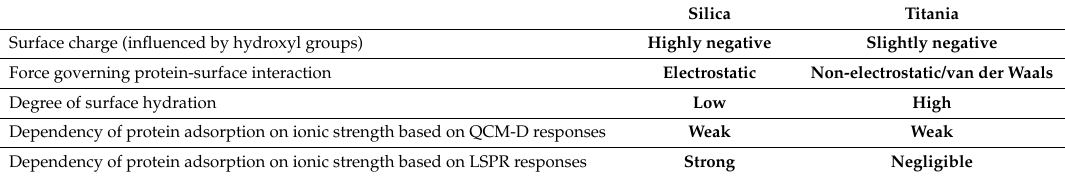
Table 1. Summary of the differences in surface properties between silica and titania and the resulting differences in measurement responses obtained from QCM-D and LSPR measurement techniques. Silica